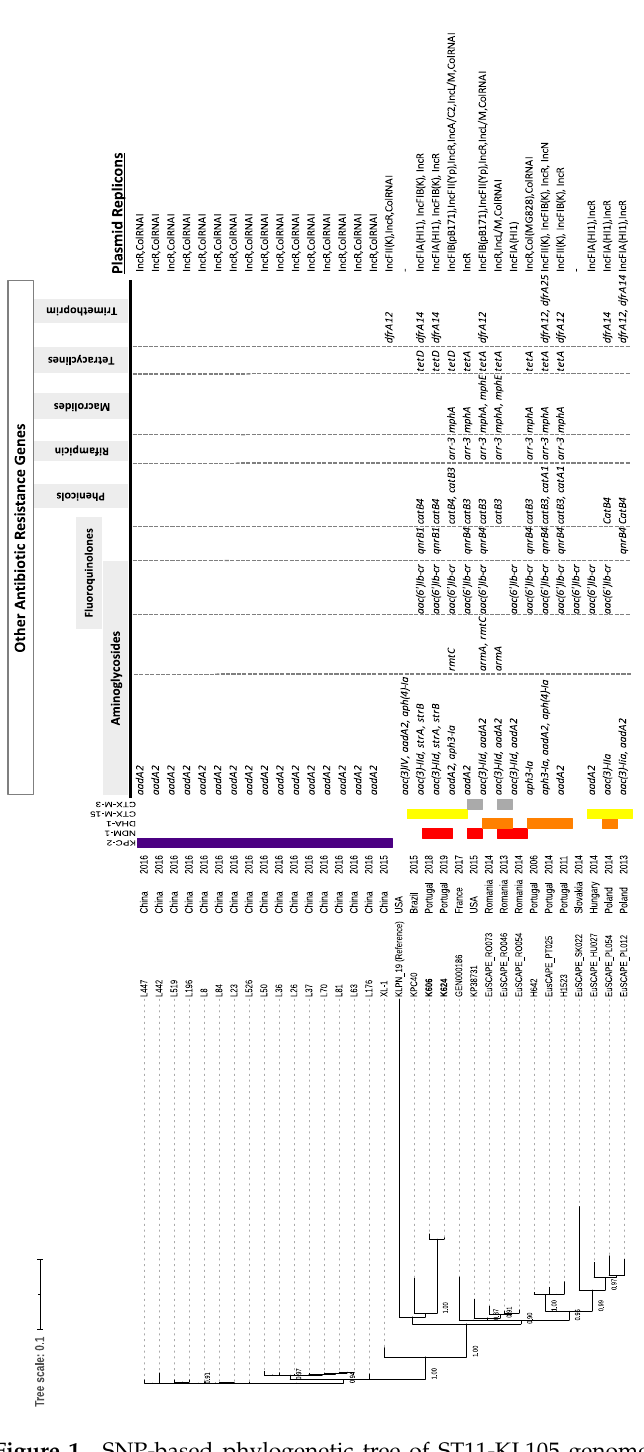
Figure 1. SNP-based phylogenetic tree of ST11-KL105 genomes and heatmap of antimicrobial resistance genotype. Genomes sequenced from this study (shown in bold) were compared with those from 28 other ST11-KL105 strains deposited in public databases (accessed on 5 November 2019). Phylogenetic tree was obtained using the SNP method of CSI phylogeny with default parameters and the reference strain KLPN_19, the closest ST11 with KL107 (accession number GCF_003861305.1). Country and year of isolation are shown, as represented in metadata, as well as their content of acquired beta-lactamases (ESBL, acquired AmpC and carbapenemases), other antibiotic resistance genes and replicons. Numbers in the left indicate bootstrap values >0.85, calculated based on the maximum-likelihood